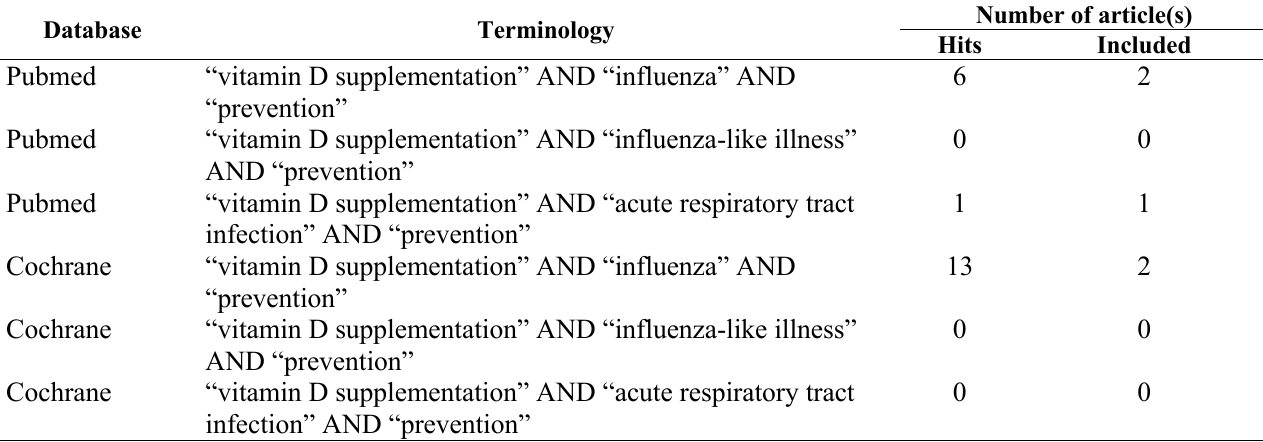
Table 1. Keyword and the numbers of included-articles